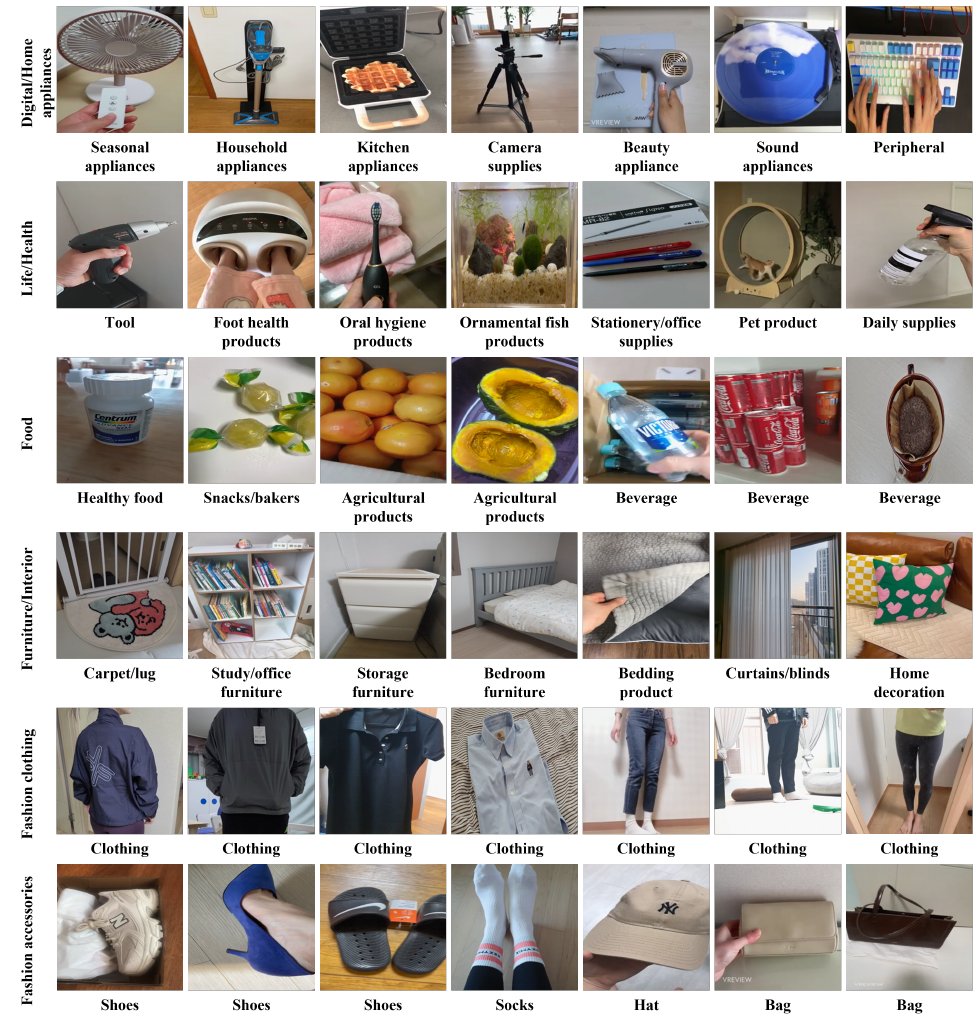
Figure 2. Videos of the hierarchical category of VERD. The category to the left of images represents the Level-0 category, and the category below images represents the Level-1